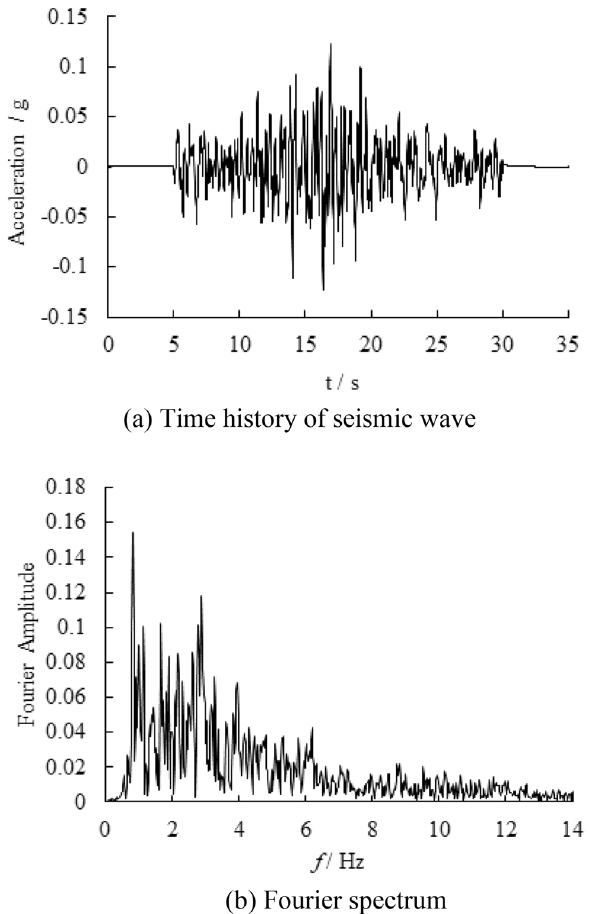
Figure 4. The time history of seismic wave and fourier